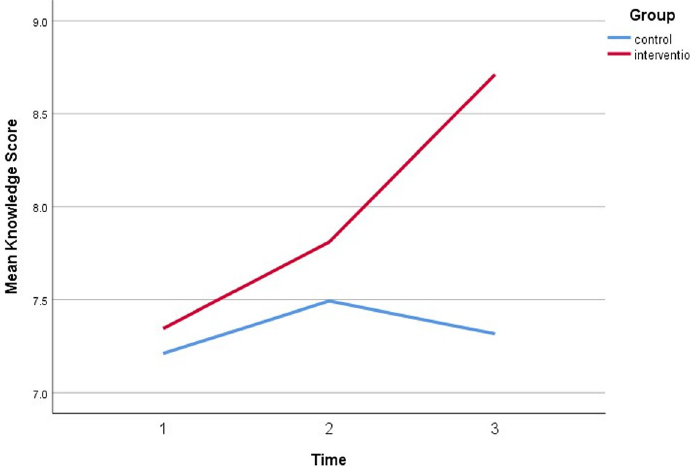
Fig 2. A plot of knowledge scores among respondents, showing the interaction between groups and time.